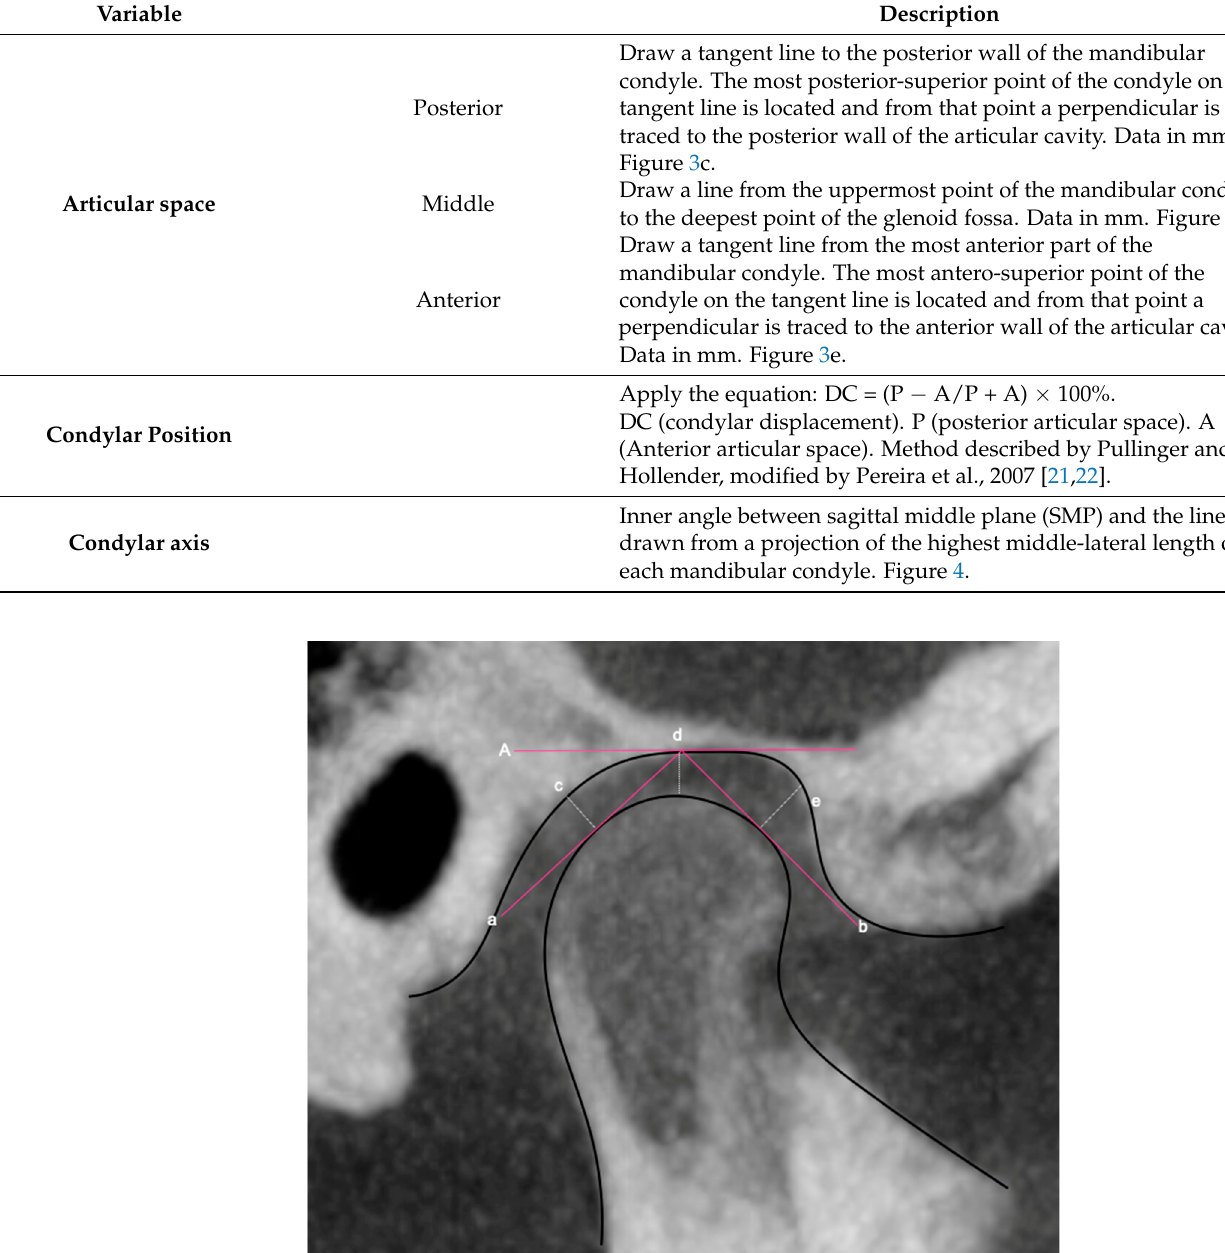
Figure 4. References to obtain the angular measurement of condylar axis with respect to the mid-sagittal plane (MSP). a. Lateral extreme of the mandibular condyle. b. Medial extreme of the mandibular condyle. c. Inner angle between MSP and the line drawn from the projection of higher mid-lateral length of each condyle.